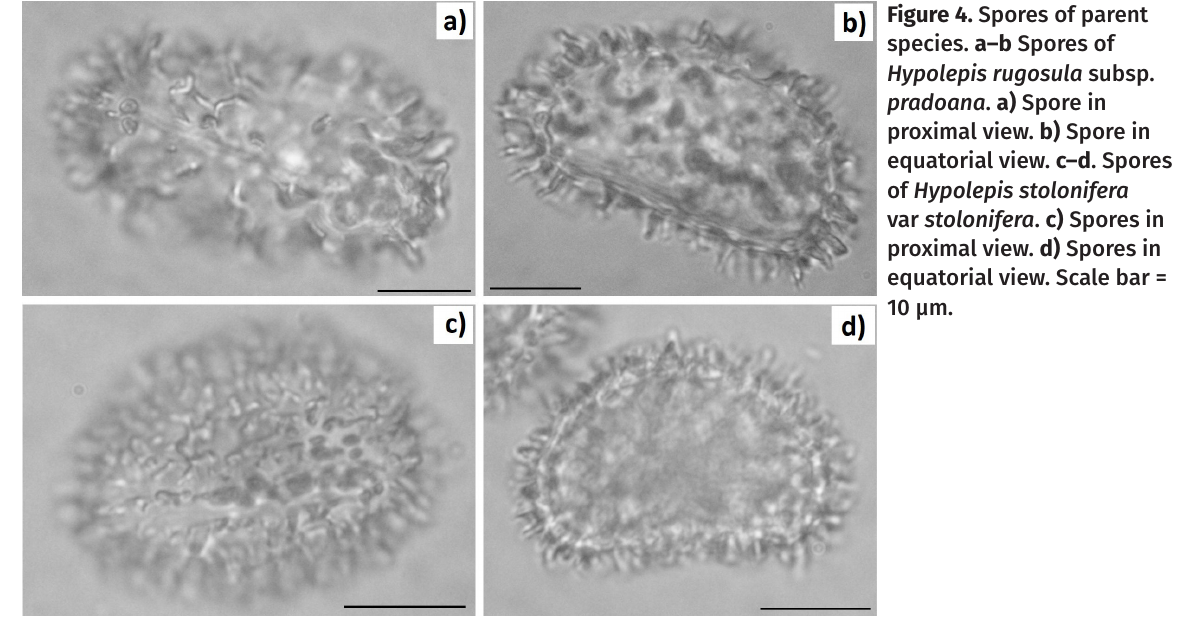
Figure 4. Spores of parent species. a–b Spores of Hypolepis rugosula subsp.